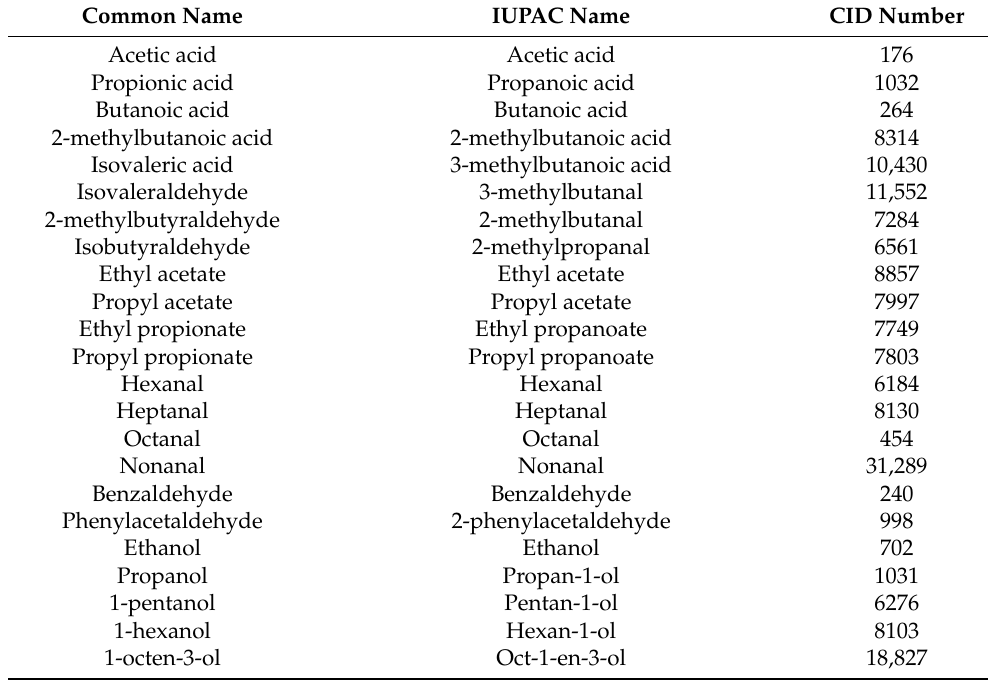
Table A2. Names of compounds described as common names, IUPAC names and PubChem CID